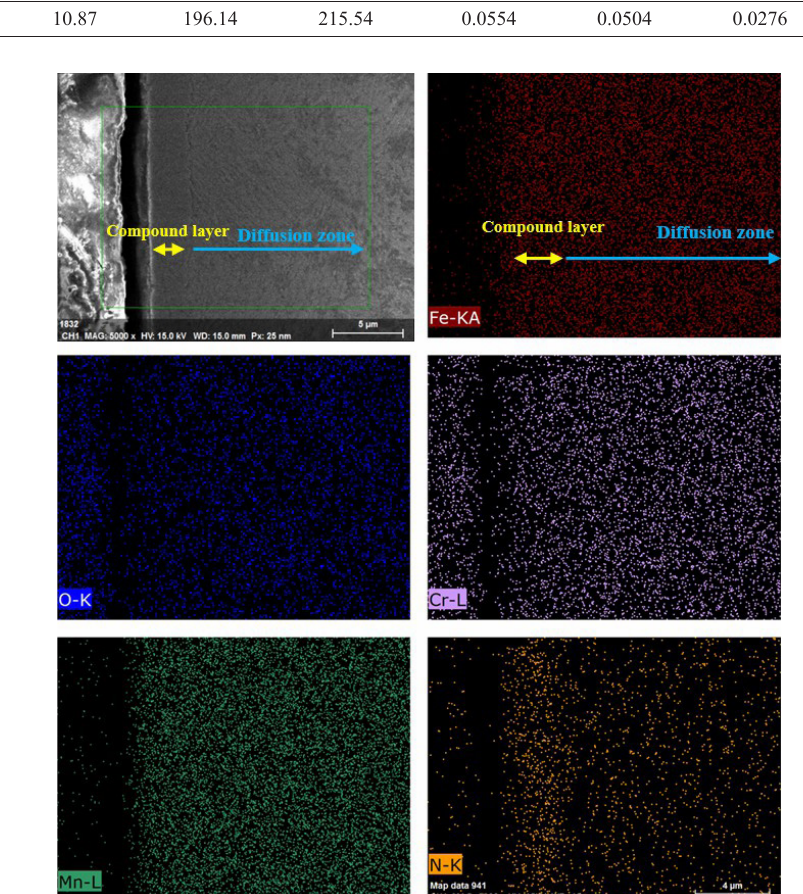
Figure 5. EDS elemental mapping scan along the cross-section of the nitrided layer of the HCSPN sample.